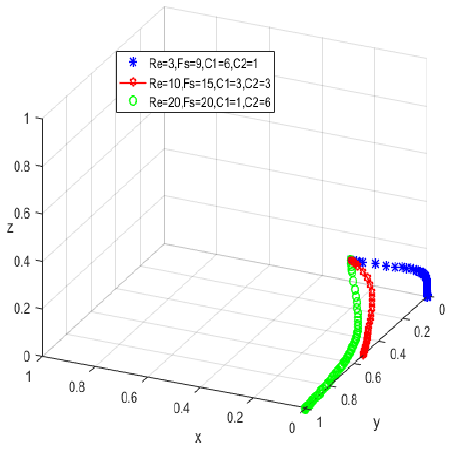
Figure 13. Trend graph for L P .